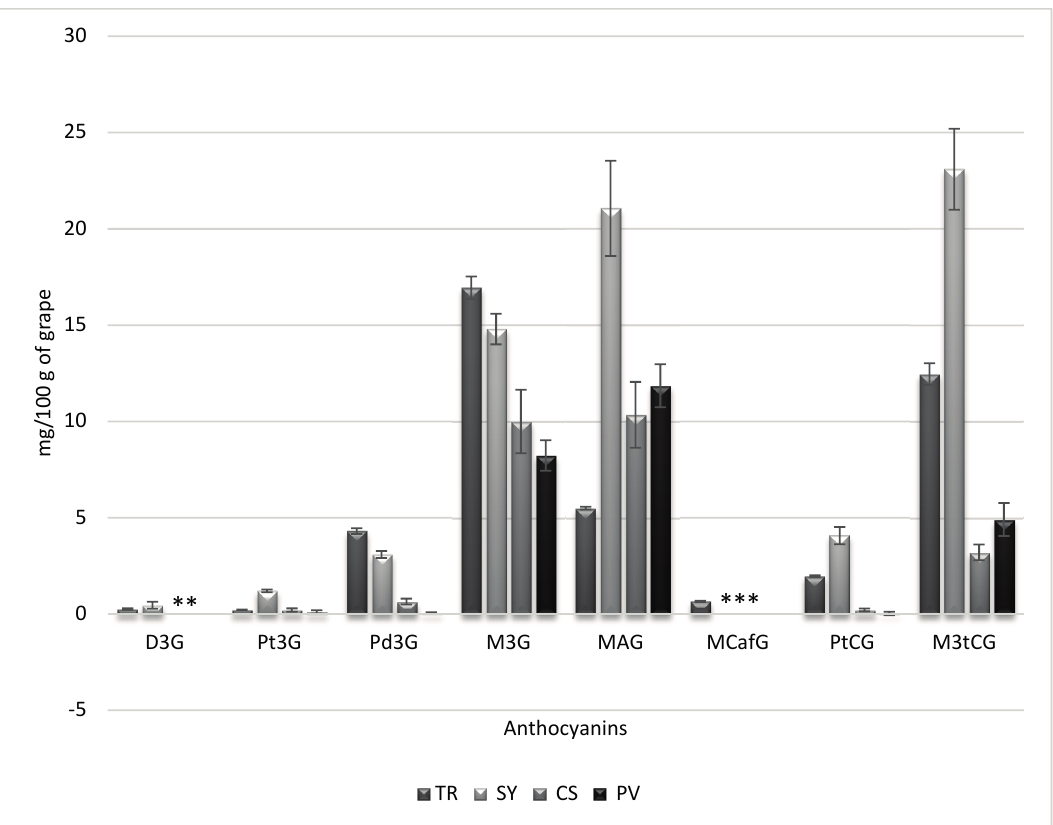
Figure 3. Anthocyanin levels obtained for the different grape varieties (TR: Tintilla de Rota, Sy: Syrah, CS: Cabernet Sauvignon, PV: Petit Verdot). **: There are two non detected compounds; ***: There are three non detected